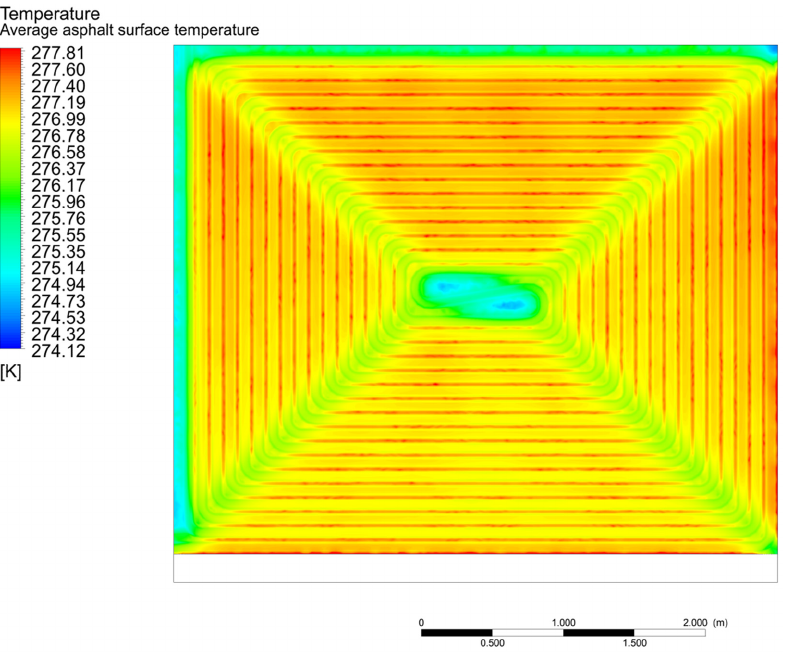
Figure 8. A 2D plot of the temperature distribution on the asphalt surface from case 5.2.1.